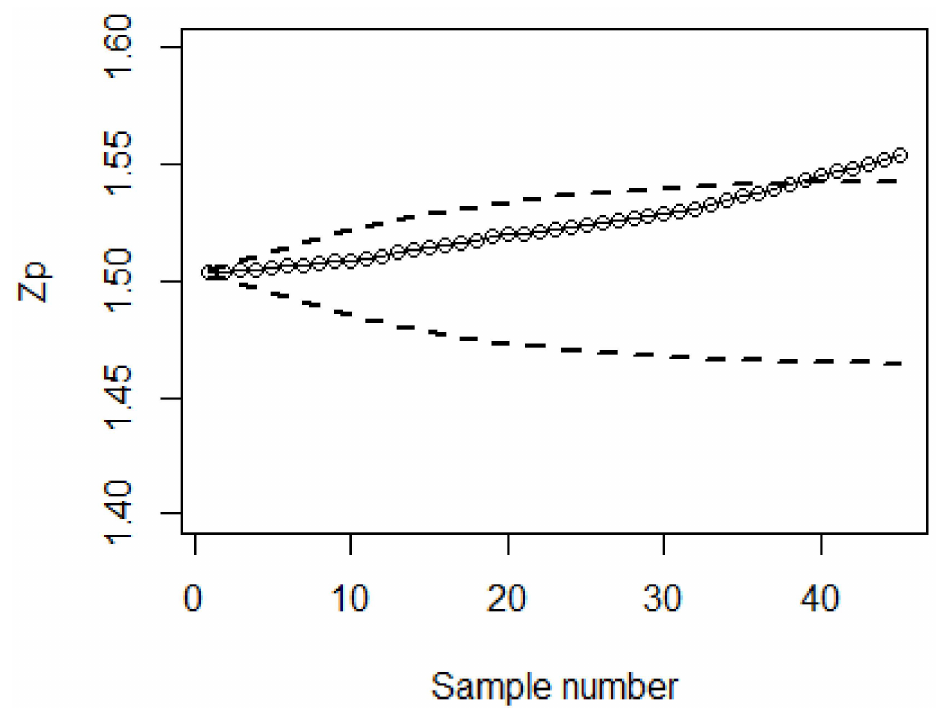
Figure 5. Bayesian HEWMA control chart using posterior and posterior predictive distribution under SELF for